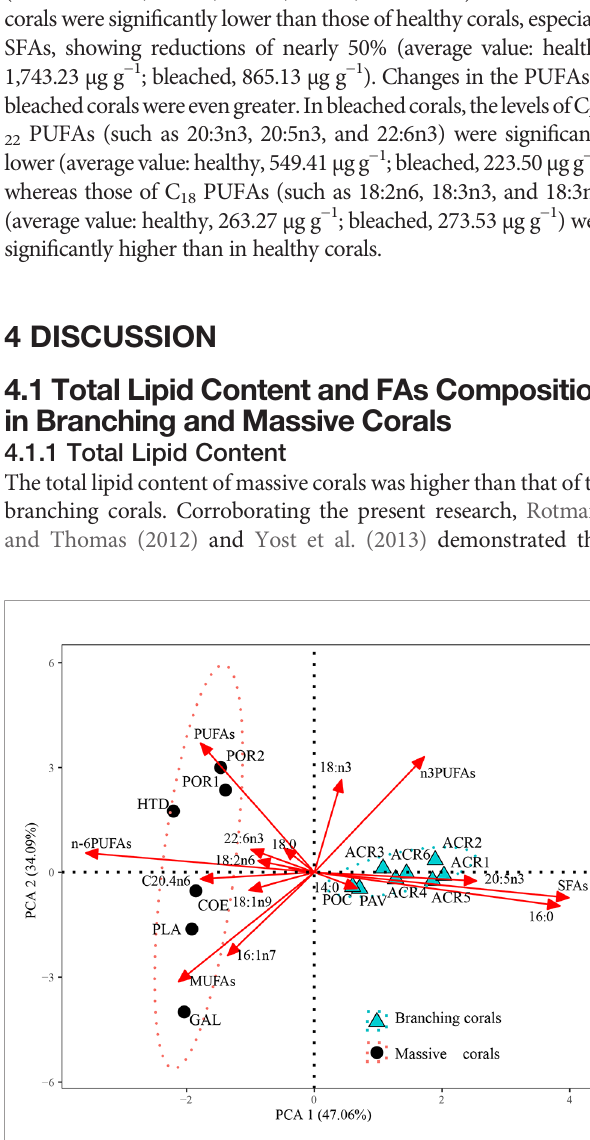
each species ( p < 0.05).